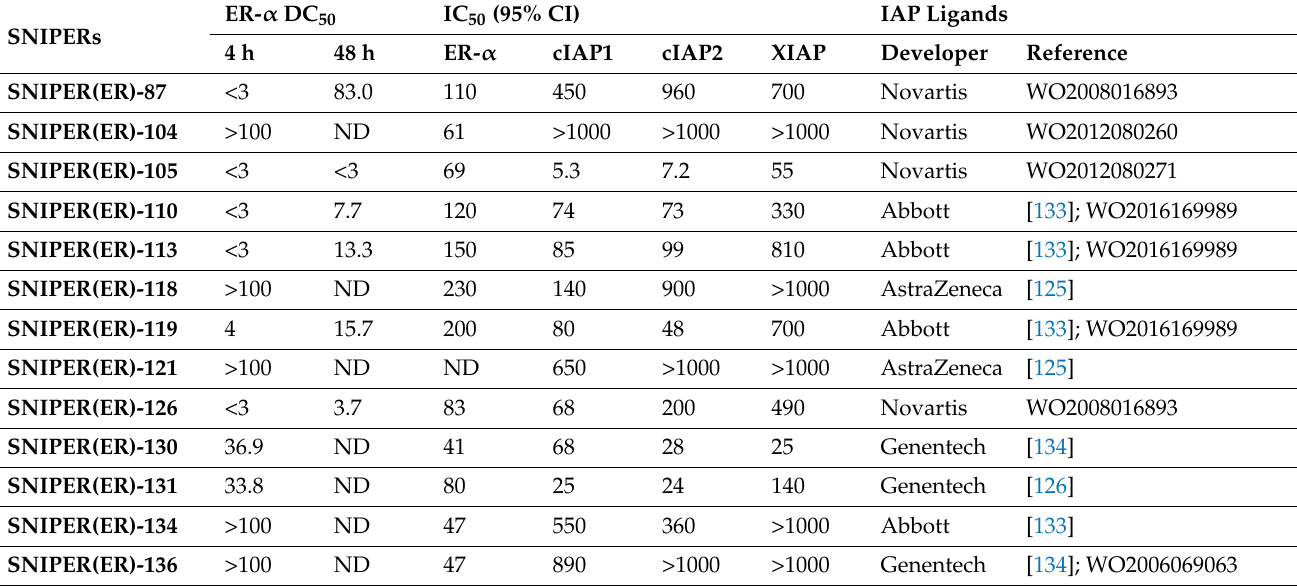
Table 2. In vitro binding affinities (IC 50 ) of synthesized SNIPERs to ER- α and IAPs. The table was reproduced under the terms of the Creative Commons CC-BY license